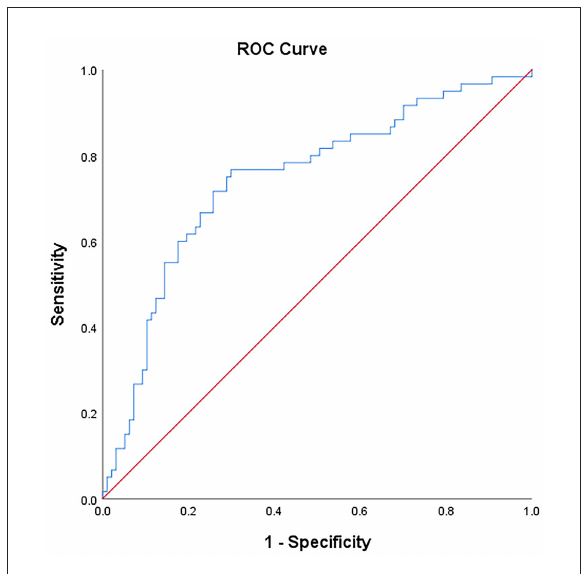
FIGURE2 The ROC curve of BPD and the s-cumulative fluid